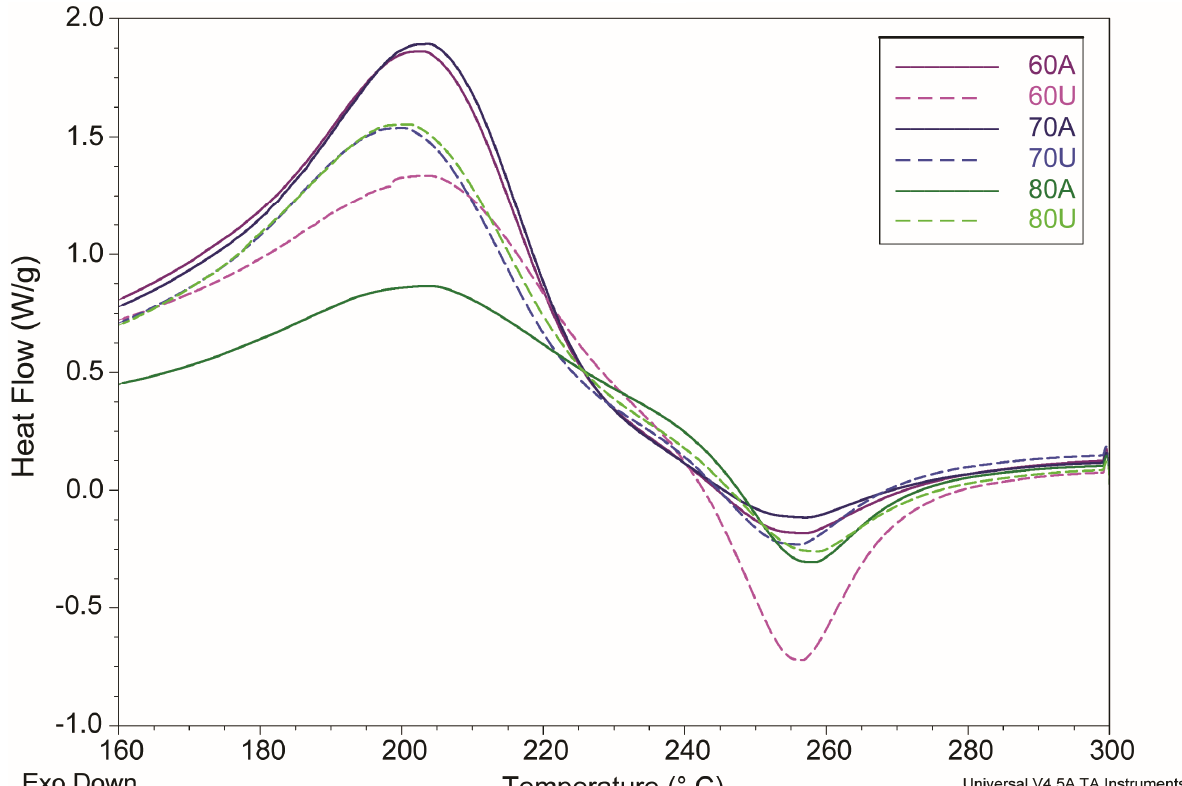
Figure 5. Fragments of DSC thermograms of citrus pectins extracted at 60 °C, 70 °C, and 80 °C by (A) citric acid in pH 1.5 and (U) citric acid in pH 1.5 with the addition of ultrasounds,